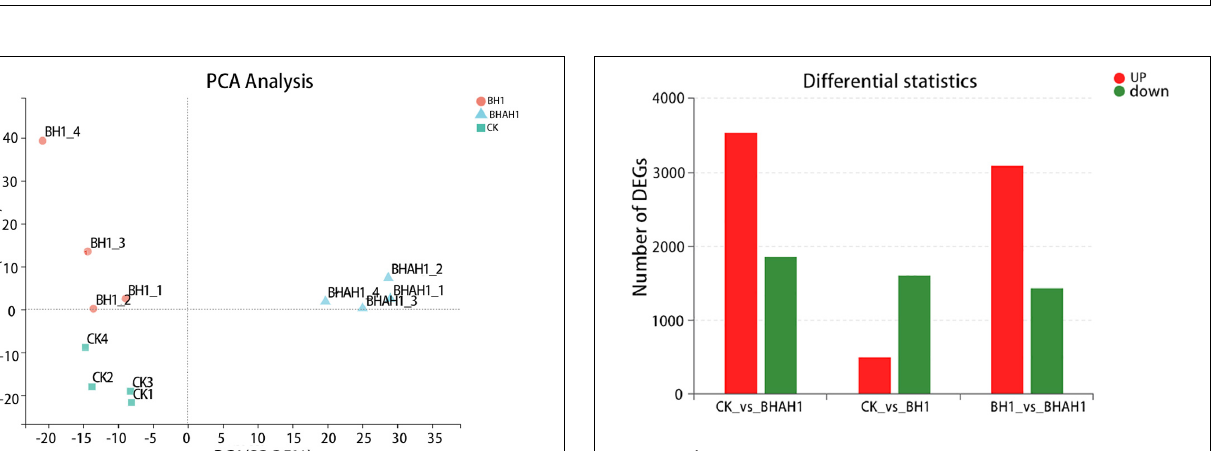
FIGURE 5 | Differentially down-regulated gene expression in each group. Red, up-regulated genes; green, down-regulated genes. The molecular mechanism of berberine hydrochloride